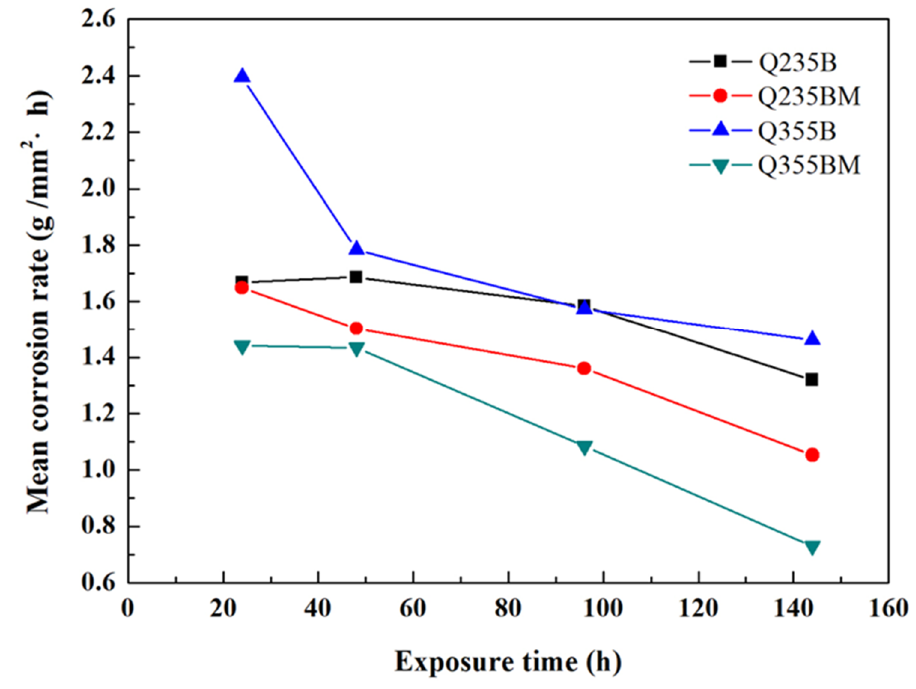
Figure 2. Corrosion rates obtained in wet-dry cycle immersion tests.